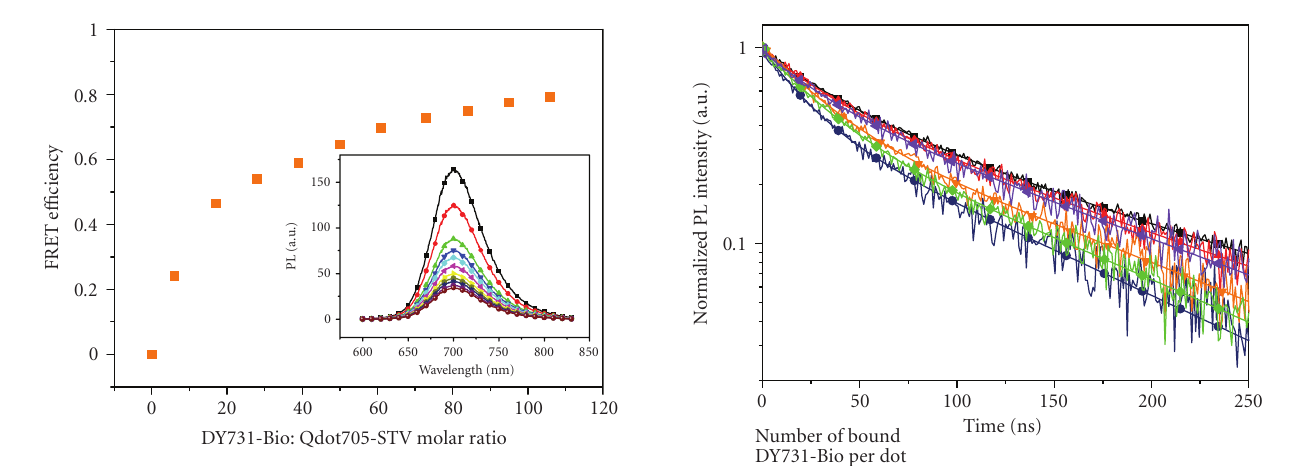
Figure 4: The scattered plot represents the FRET e ffi ciency as a function of DY731-Bio to Qdot705-STV molar concentration ra- tio of nonfiltered mixture. The e ffi ciency calculated is based on the extracted Qdot705-STV spectra (from Spectra A in Figure 3) shown in the inset.